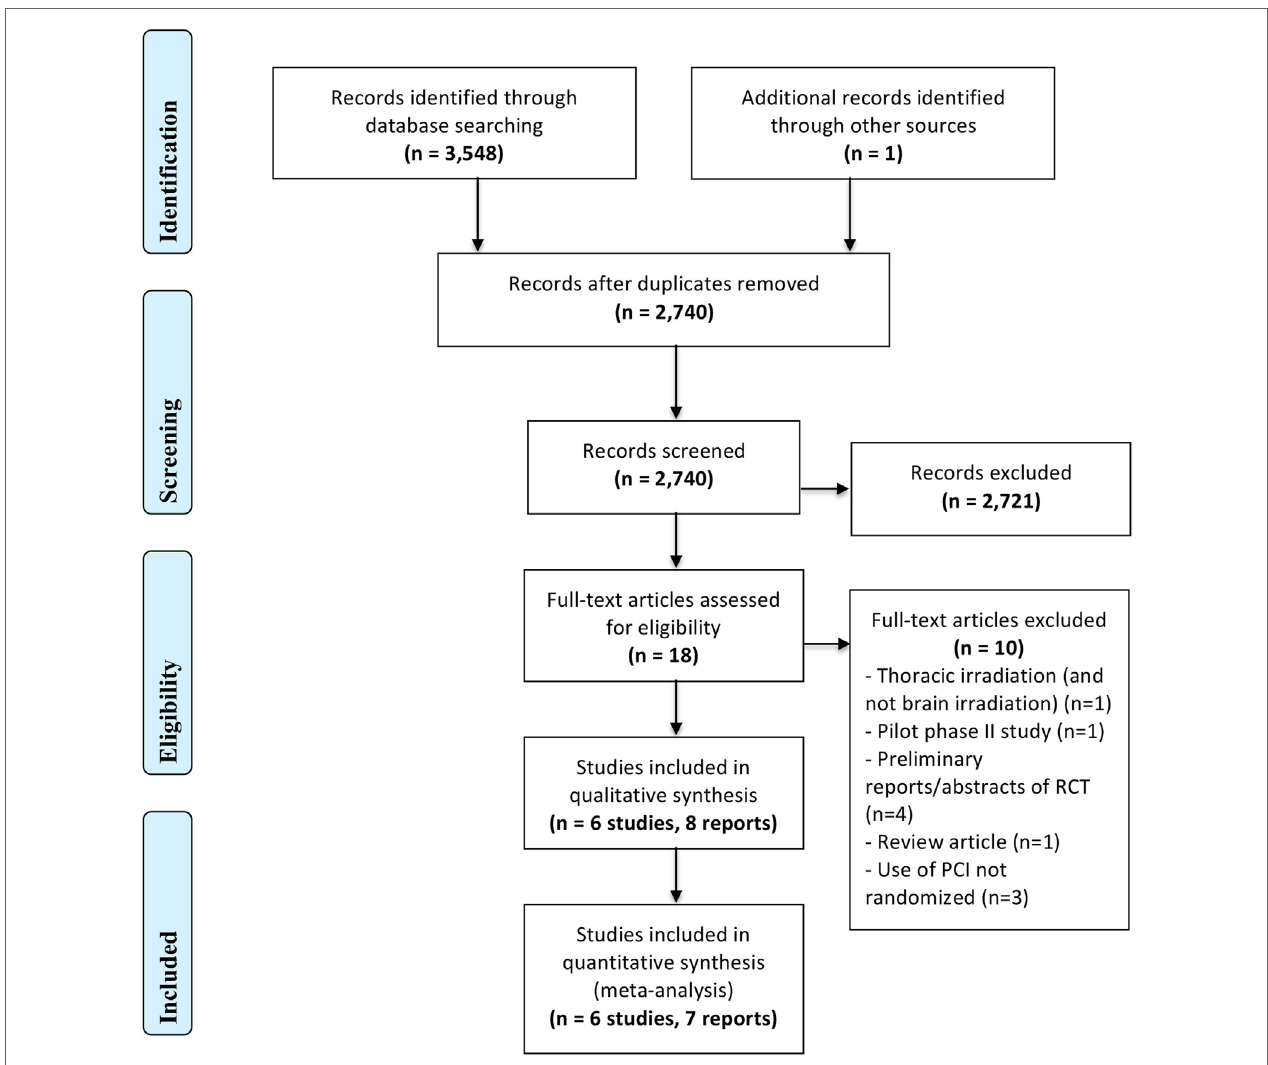
FigURe 1 | PRISMA Flow